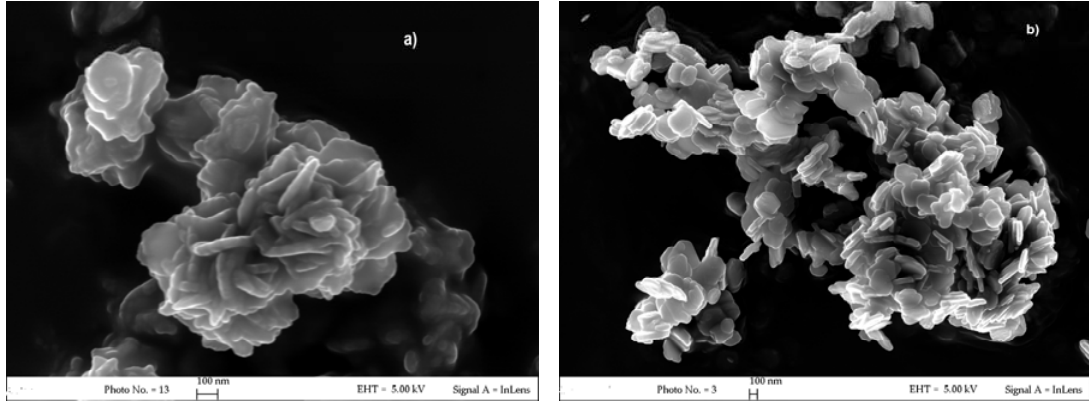
Figure 3. FESEM images of ( a ) the NiAl-NO 3 LDH, ( b ) the MgAl-CO 3 LDH.